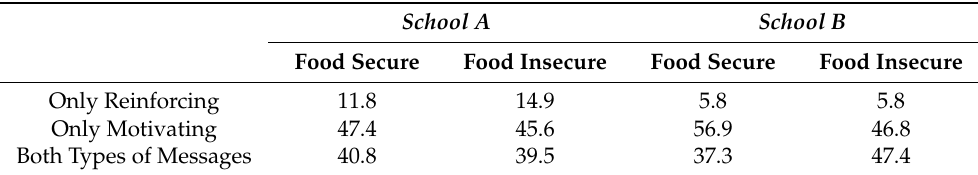
Table 4. Percentage of food secure and food insecure students (by self-report) within each school by health promotion message type †. Chi-squared testing within a school was non-significant.